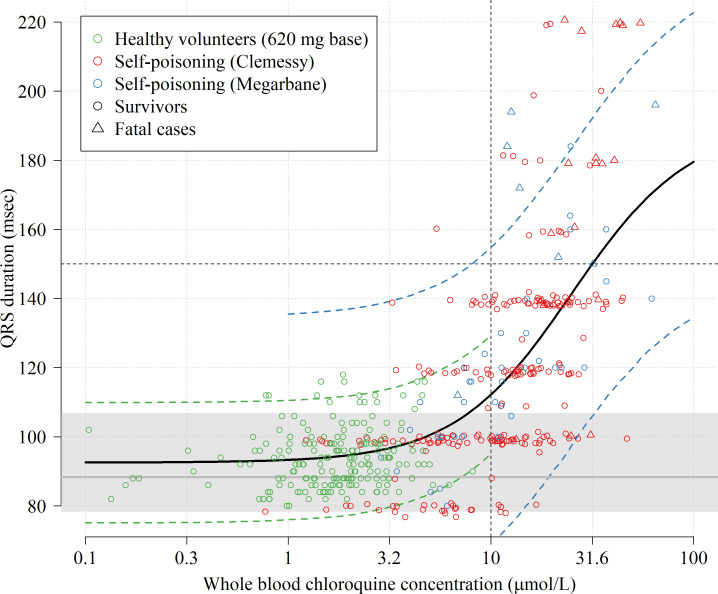
Electrocardiograph QRS interval duration as a function of whole blood chloroquine concentrations.The data shown in the scatter plot are from 16 healthy volunteers who took a single 620 mg base oral dose (green circles, 192 paired concentration-QRS data-points, plasma concentrations were multiplied by 4) and 290 chloroquine self-poisoning patients (red and blue, hospital admission concentrations). Random normal jitter (standard deviation of 1 ms) was added to the Clemessy cohort self-poisoning QRS values for improved visualization. Survivors are shown as circles and fatal cases as triangles. The self-poisoning electrocardiograph QRS values from the Clemessy series (Clemessy et al., 1995; Clemessy et al., 1996) were read manually and are adjusted for a bias term (see Materials and methods, non-adjusted data are shown in Appendix 5). The grey line (grey area) shows the estimated median QRS duration (range) in the 16 healthy volunteers in absence of measurable drug. The thick black line shows the mean posterior Emax sigmoid regression model, fitted to the pooled data. The dashed green and blue lines show the posterior predictive distribution under the error distributions for the healthy volunteers and Megarbane self-poisoning cohort (smaller measurement error than in the Clemessy cohort), respectively (see Materials and methods for the full specification of the model). Note that the Emax regression model does not account for concentration-dependent heteroskedasticity but only inter-individual variation for healthy volunteers and inter-study variation (differences in measurement).